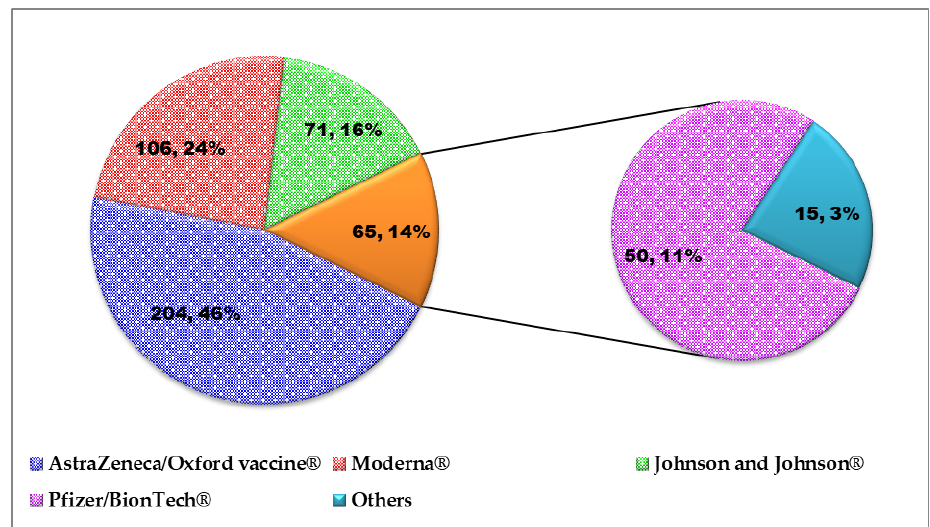
Figure 7. Distribution of COVID-19 vaccine brands received by vaccinated respondents ( n = 446) surveyed for vaccine hesitancy in Nigeria.